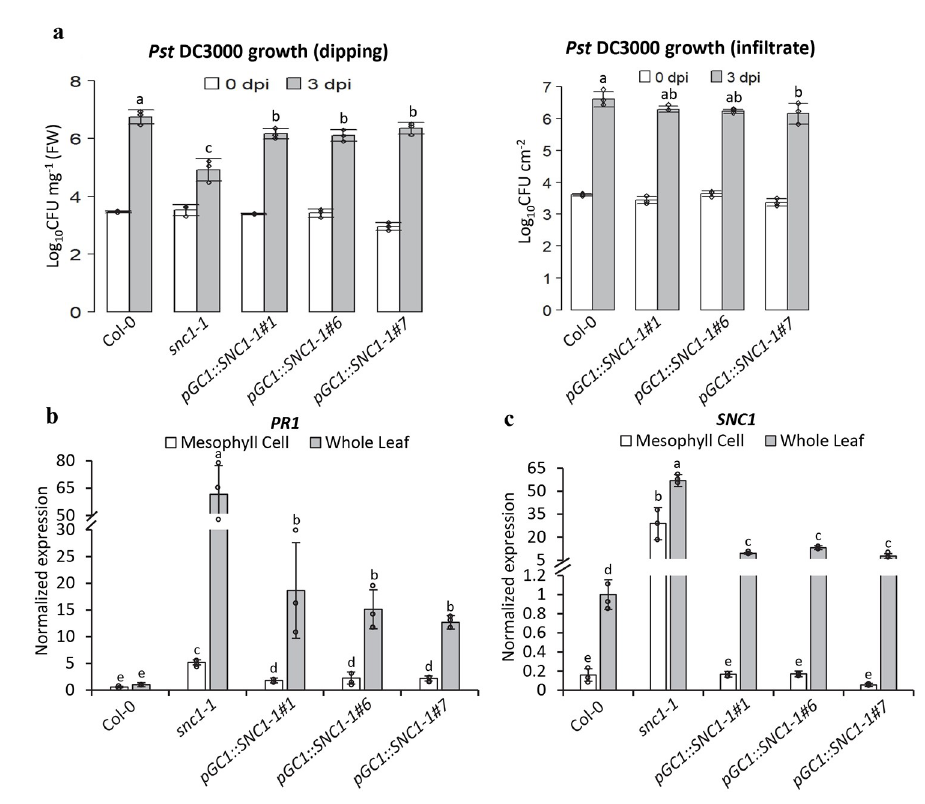
Fig 5. Expressing the active mutant gene SNC1-1 in guard cells enhances whole plant resistance to Pst DC3000. ( a ) Growth of Pst DC3000 at 0 dpi and 3 dpi after dipping or infiltration inoculation. Results are from three biological repeats in one experiment representative of two independent experiments. Error bars indicate SDs. Different letters indicate statistically significant differences in pathogen growth between different genotypes ( p < 0.05, student’s t test). ( b , c ) Transcript abundance of PR1 ( b ) and SNC1 ( c ) in mesophyll cells and whole leaves of indicated plant lines assayed by qPCR. Plants were grown for 5 weeks and RNA was harvested from mesophyll cells and rosette leaves. Results represent three biological replicates. The expression of target genes was normalized to reference gene ACTIN , and relative to their expression in whole leaves of Col-0 which was set as 1. Values are arithmetic means ± S.E. Different letters indicate statistically significant differences of the gene expression between indicated plant lines ( p < 0.05, based on one-way ANOVA followed by Duncan’s new multiple range